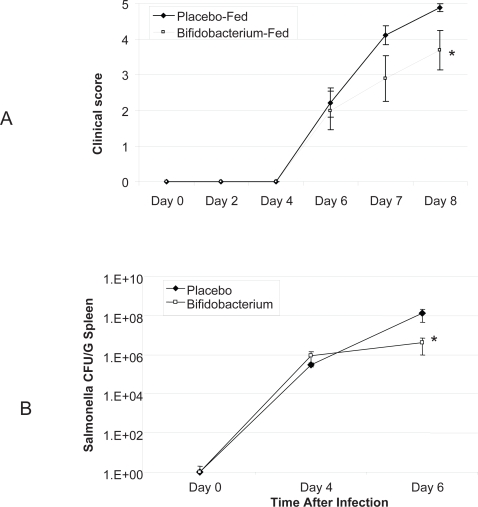

B. infantis reduces S. typhimurium disease severity and systemic translocation.(A) Macroscopic clinical scoring of mice infected with S. typhimurium reveals a significant reduction in B. infantis pre-fed mice disease symptoms 8 days following initial infection (n = 10/group); (B) S. typhimurium numbers were reduced in the spleens and livers of B. infantis fed mice 6 days following infection (n = 18/group). *p<0.05 versus placebo.